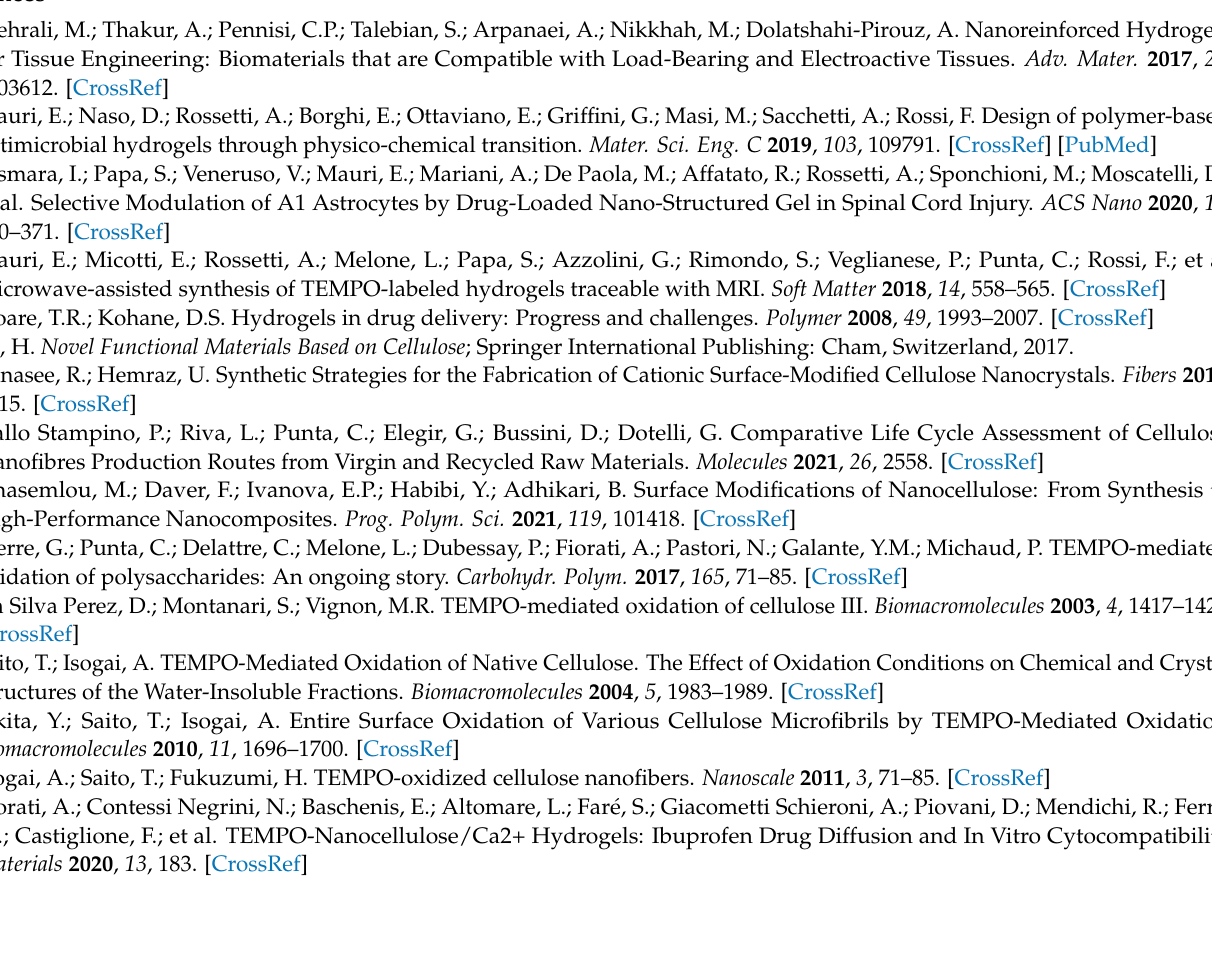
NFs-CaPGO, Figure S6: SEM images of TOCNFs CaP after mineralization (28 d) and washing step, Figure S7: SEM images of TOCNFs CaPGO after mineralization (28 d) and washing